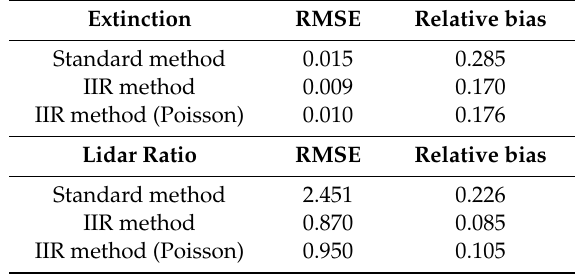
Figure 4. Comparisons of the results obtained by the standard method (left panel) and the IIR method (right panel) based on the simulation experiments. ( a , c , e ) are obtained by the standard method, which represent the extinction coe ffi cient, the absolute error of the extinction coe ffi cient of the true values and the retrieval values, and the lidar ratio, respectively. ( b , d , f ) are obtained by the IIR method. The dashed lines in ( f ) are selected for further analysis, whose profile numbers are 19, 48, 78, and 99, respectively. Table 2. Error analysis of optical properties. RMSE: root mean square